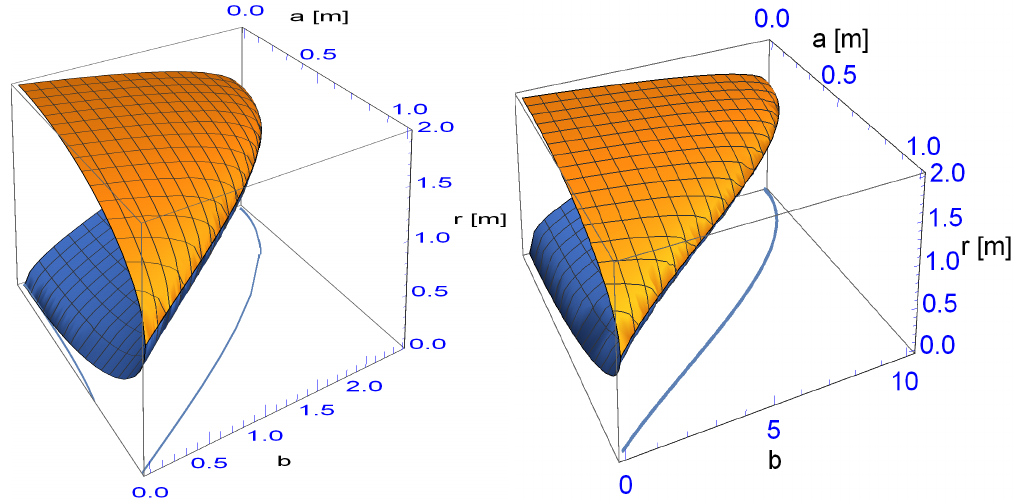
Figure 8. Shown is the surface of allowed horizons for n = 3 ( left panel ) and n = 4 ( right panel ); also shown is the projected curve of the separatrix (blue curve). The vertical axis denotes r in units of m 0 = m , the x -axis the a in units of m 0 and the y -axis the b n = b parameter. The figures are obtained using (25). The corresponding MATHEMATICA [44] tool can be retrieved from